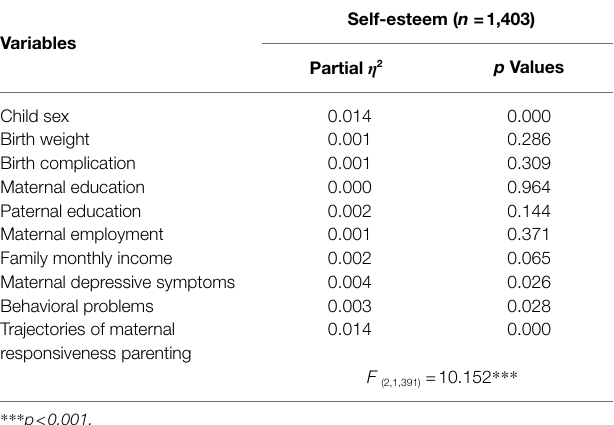
TABLE 5 | Main effects of maternal responsive parenting trajectories on self- esteem of first graders.